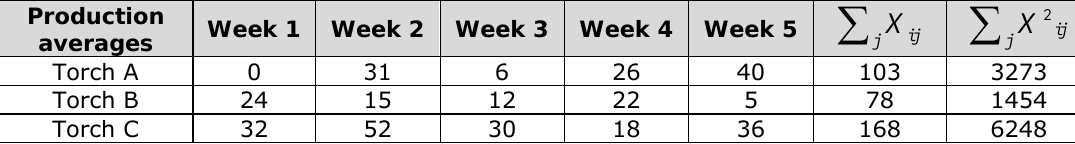
Table 11. “Modified weekly averages of production by the